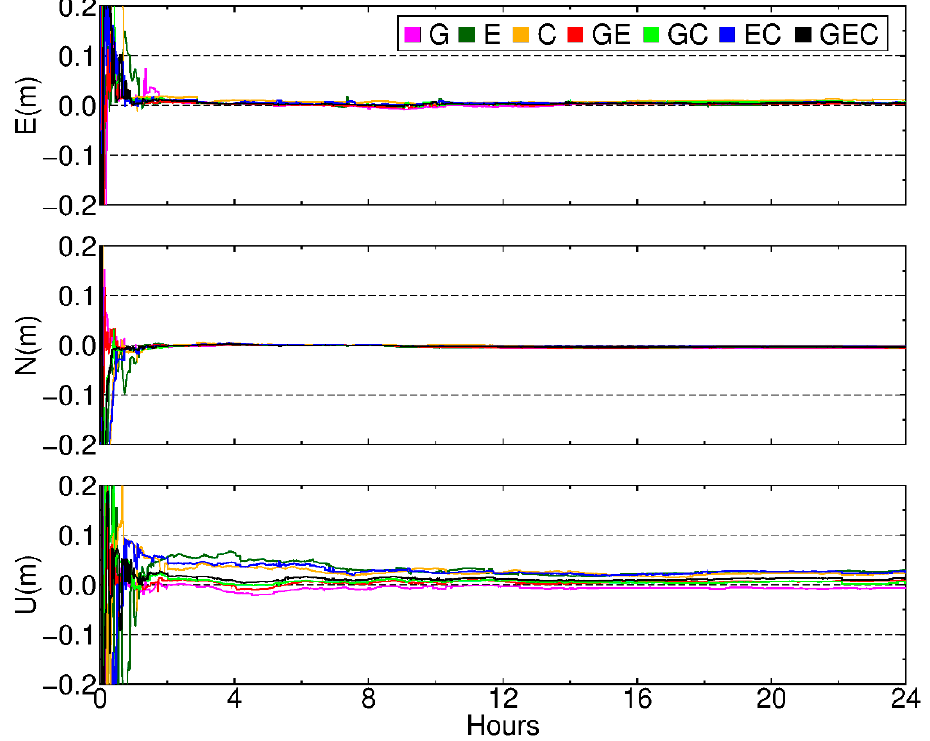
Figure 11. Comparison of the fixed results for the seven systems in the E, N, and U components, respectively, at station KAT1 on DOY 324, 2018.